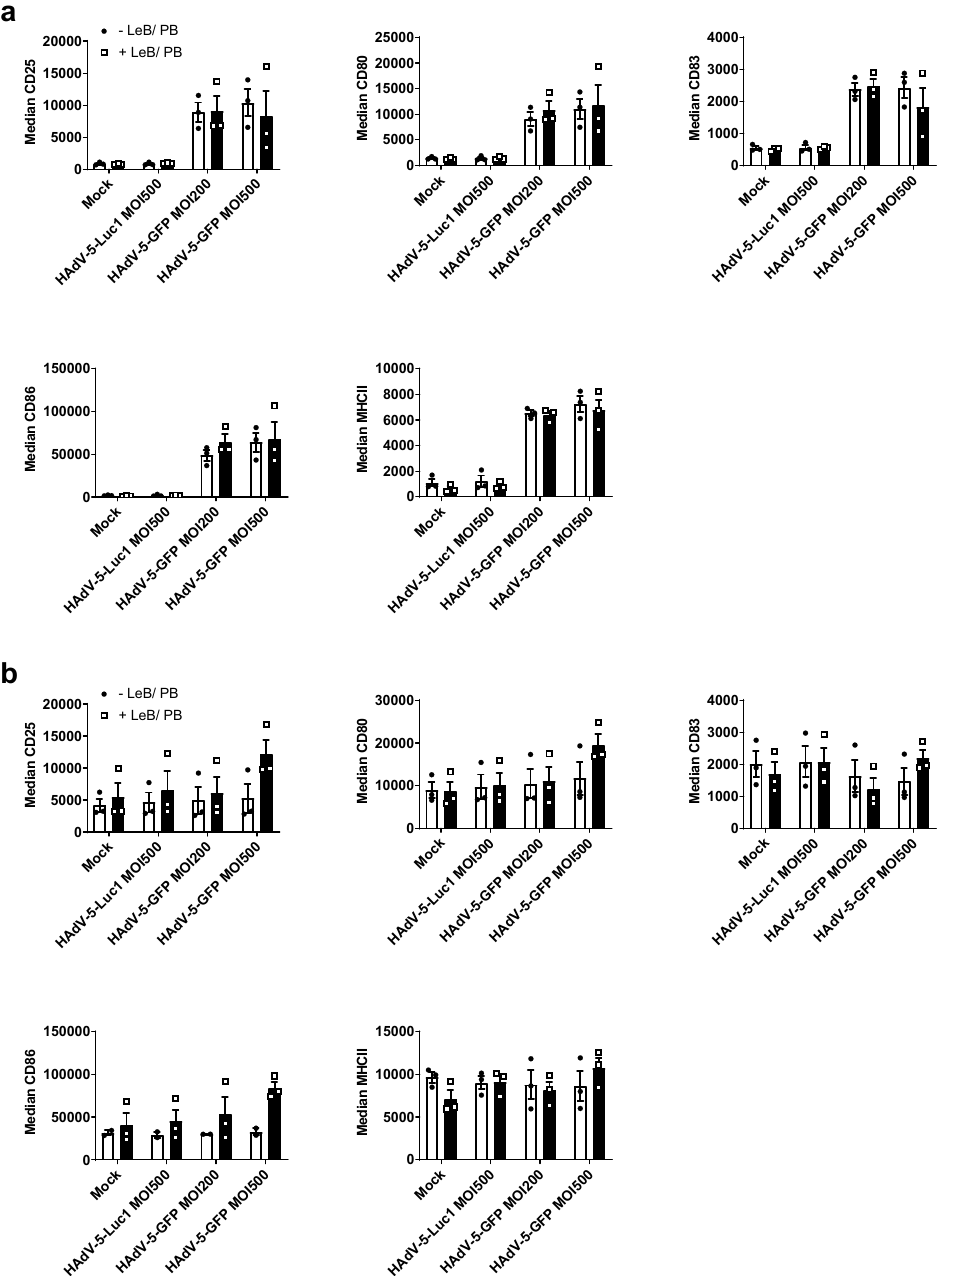
Figure 2. LentiBOOST ® /Polybrene does not impair the maturation status of BMDCs. ( a , b ) Immature and LPS-matured BMDCs were transduced with HAdV-5-Luc1 at a MOI of 500, or with HAdV-5-GFP at a MOI of 200 and 500 in combination with LentiBOOST ® /Polybrene (+LeB/PB) or a water control, for 48 h. As a negative control, cells were mock transduced (“Mock”). Flow cytometric analyses regarding CD25-, CD80-,CD83, CD86- and MHC-II expression of iBMDCs ( a ) and mBMDCs ( b ), presented as median fluorescent intensity of positive cells. Results are shown as mean ± SEM of three independent experiments with cells derived from different mice. Black circles represent conditions without LentiBOOST ® /Polybrene, white squares represent conditions with LentiBOOST ® /Polybrene..Two-way ANOVA and Sidak correction were performed. Bars without annotation are not significant ( p > 0.05) in comparison to the respective condition without ( − )LeB and